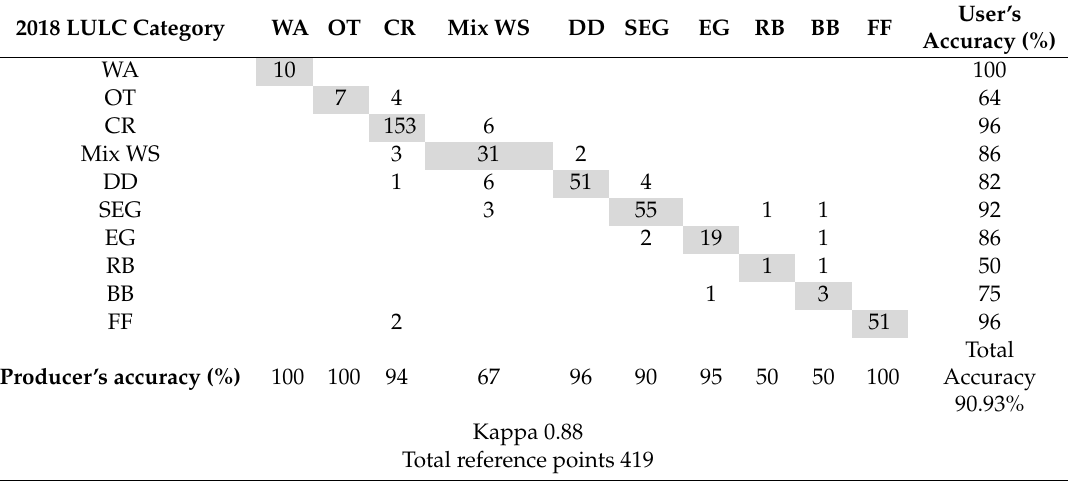
Table A7. Results of the accuracy assessment of the PBTC land cover map for 2018.